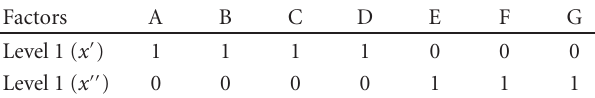
Table 3: Corresponding factors of x (cid:5) and x (cid:5)(cid:5)